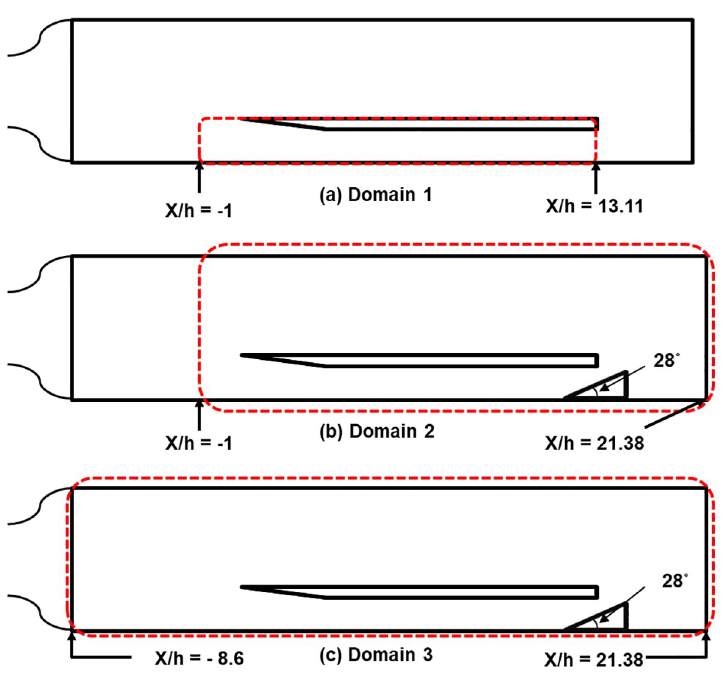
Fig 2. Configurations of the computational domain. (a) Domain 1. (b) Domain 2. (c) Domain